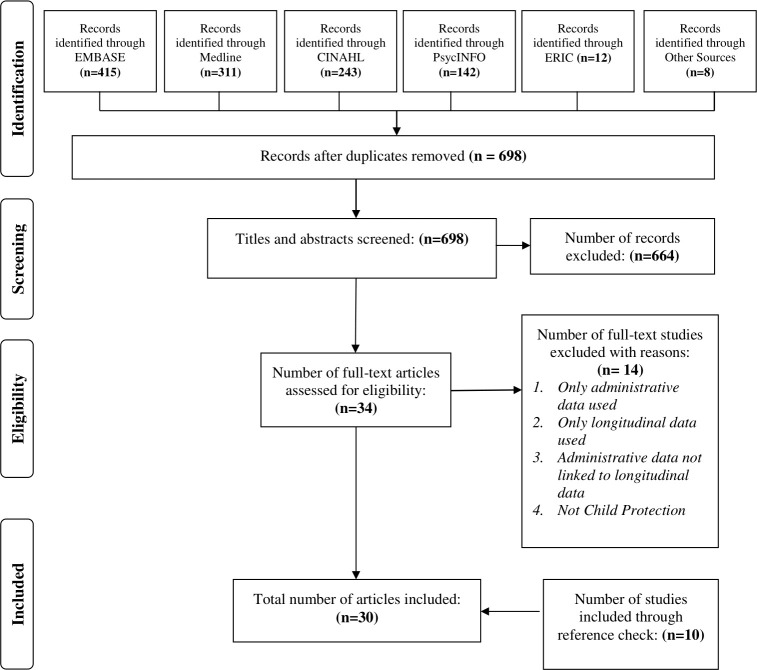
PRISMA flow diagram.